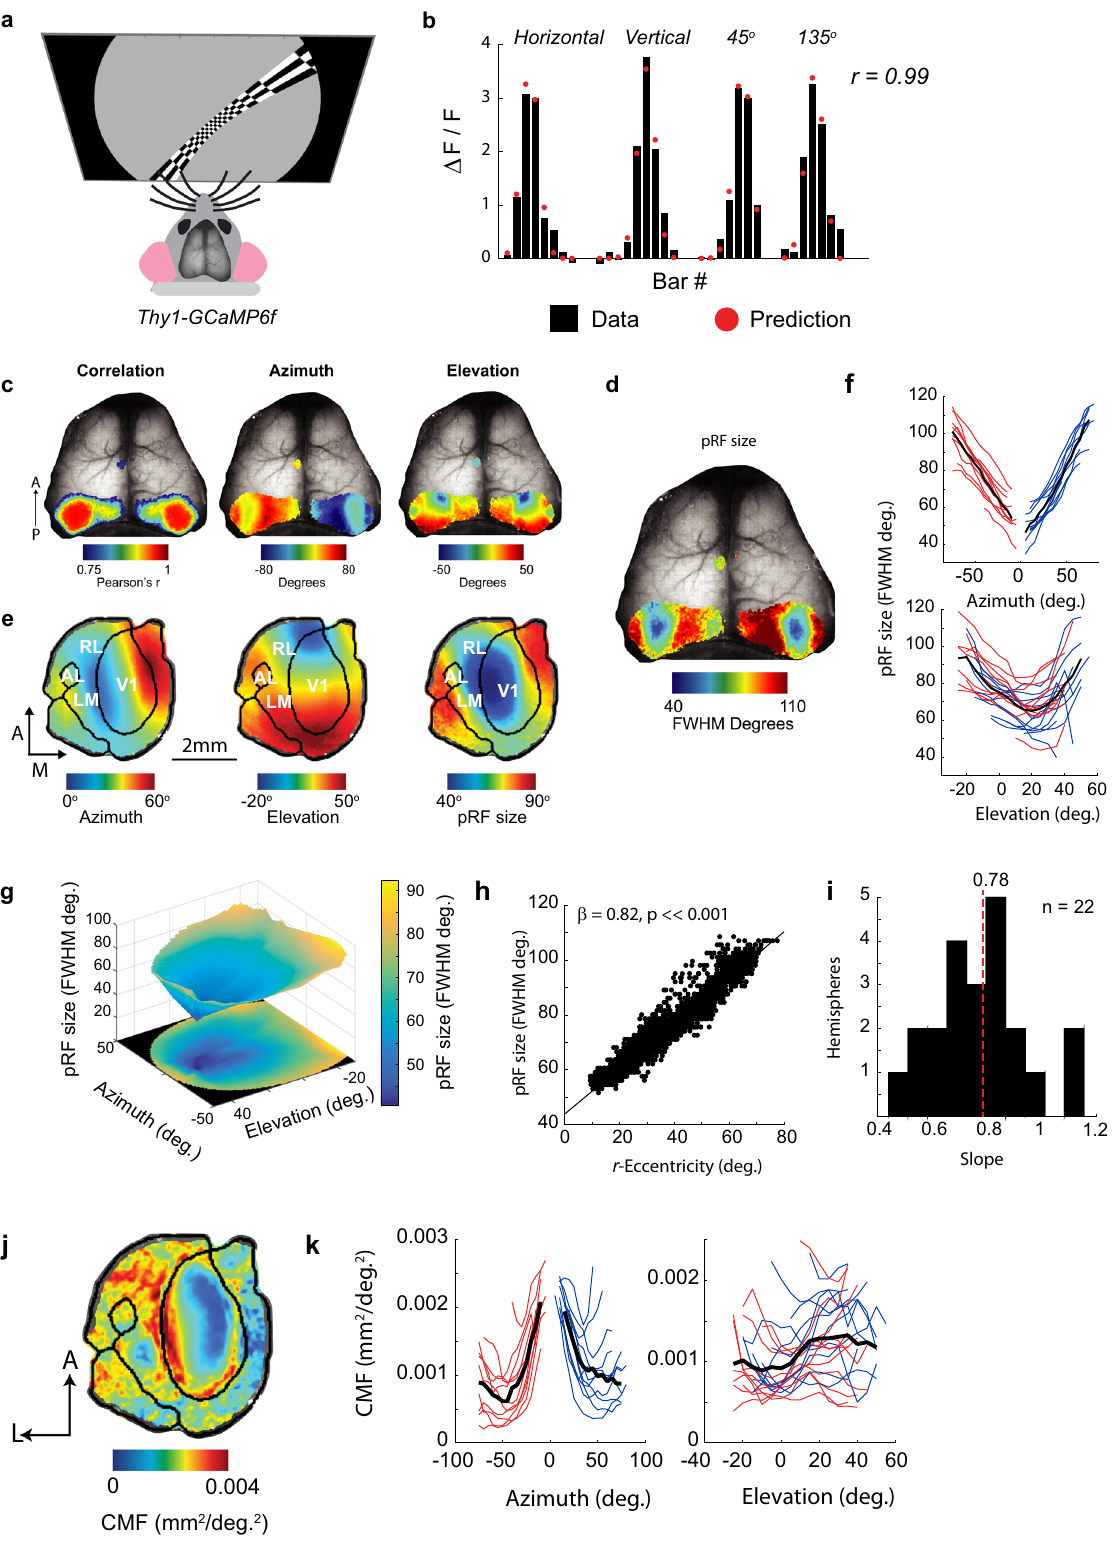
organized and RFs show scatter at a local level 14,15 . If the representation of visual space is better organized at the focea, then neighboring RFs will exhibit less scatter and the aggregate pRF, as measured by wide- fi eld imaging, will be smaller than at larger eccentricities. To independently determine the contribution of the two models to pRF size, it is necessary to fi rst estimate